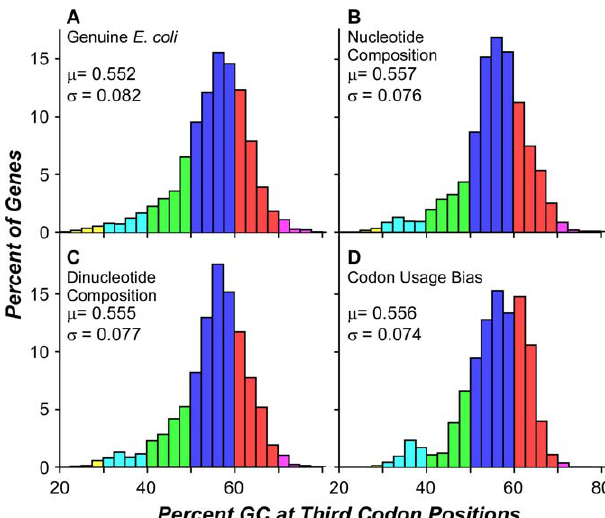
Figure 3. Variability within Genuine and Artificial E. coli Genomes Using Different Sets of Gene Models The distribution of percent GC of the third-codon positions of genes within the genuine E. coli genome (A), as well as artificial E. coli genome generated from E. coli genes clustered by SNC (B), DNC (C), or CUB (D). Artificial genomes were constructed using the optimal number of gene models (see Figure 2); l and r represent the mean and standard deviation of the distribution. For comparison between graphs, colors demarcate corresponding ranges of GC content. DOI: